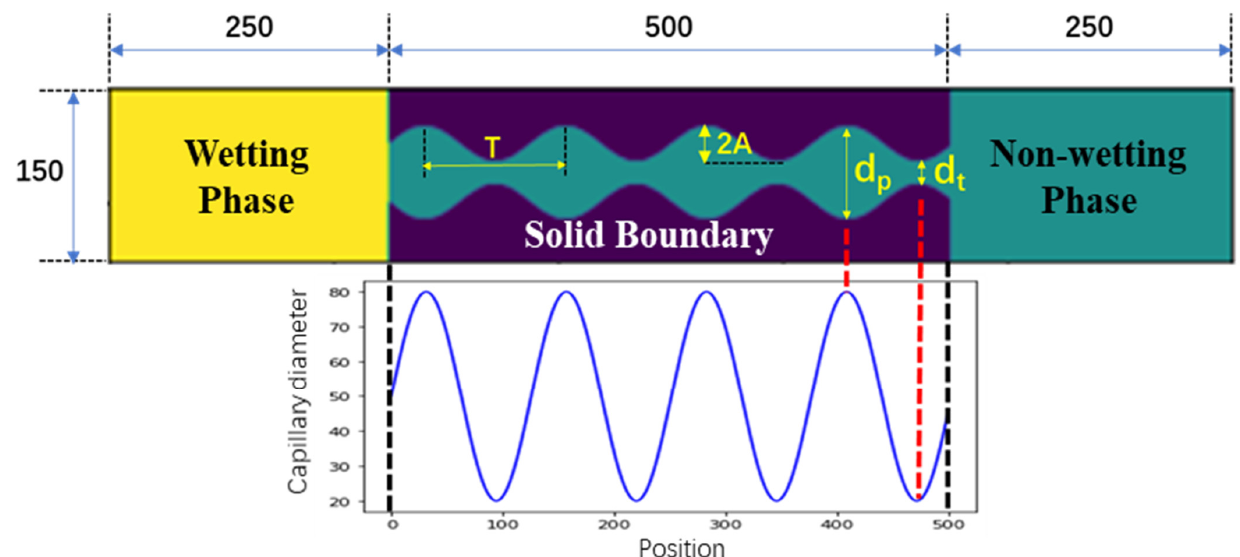
Figure 9. The schematic of variable-diameter capillary setup. (The yellow, green, and purple colors represent the wetting phase, the non-wetting phase, and the solid boundary, respectively). The wetting phase and the non-wetting phase are water and oil, respectively, and they both have a density of 1.